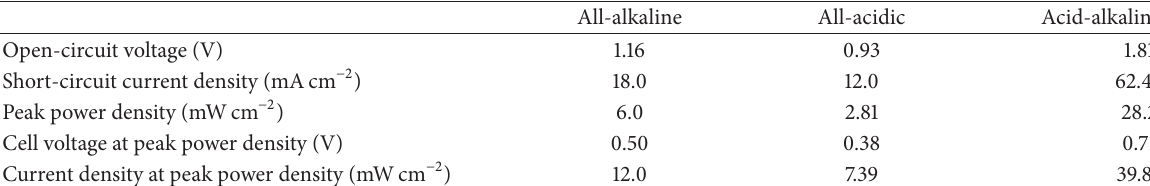
Table 3: Effect of medium on the performance of the MLSPBFC.